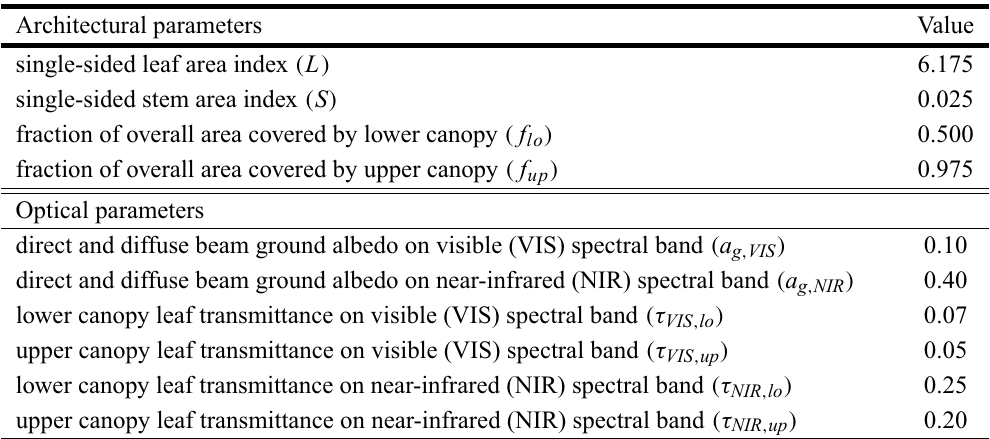
Parameters used by the